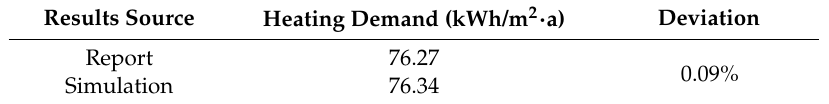
Table 4. Comparison between report and simulation results for reference building heating